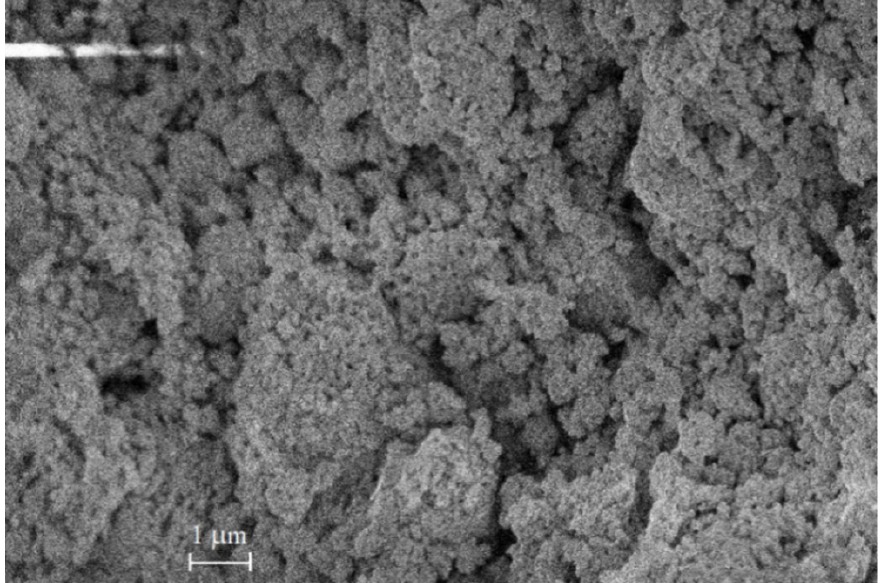
Figure 3. Scanning electron microscopy image of pressed LiNb 0.5 Ta 0.5 O 3 after initial annealing at 600 °C.